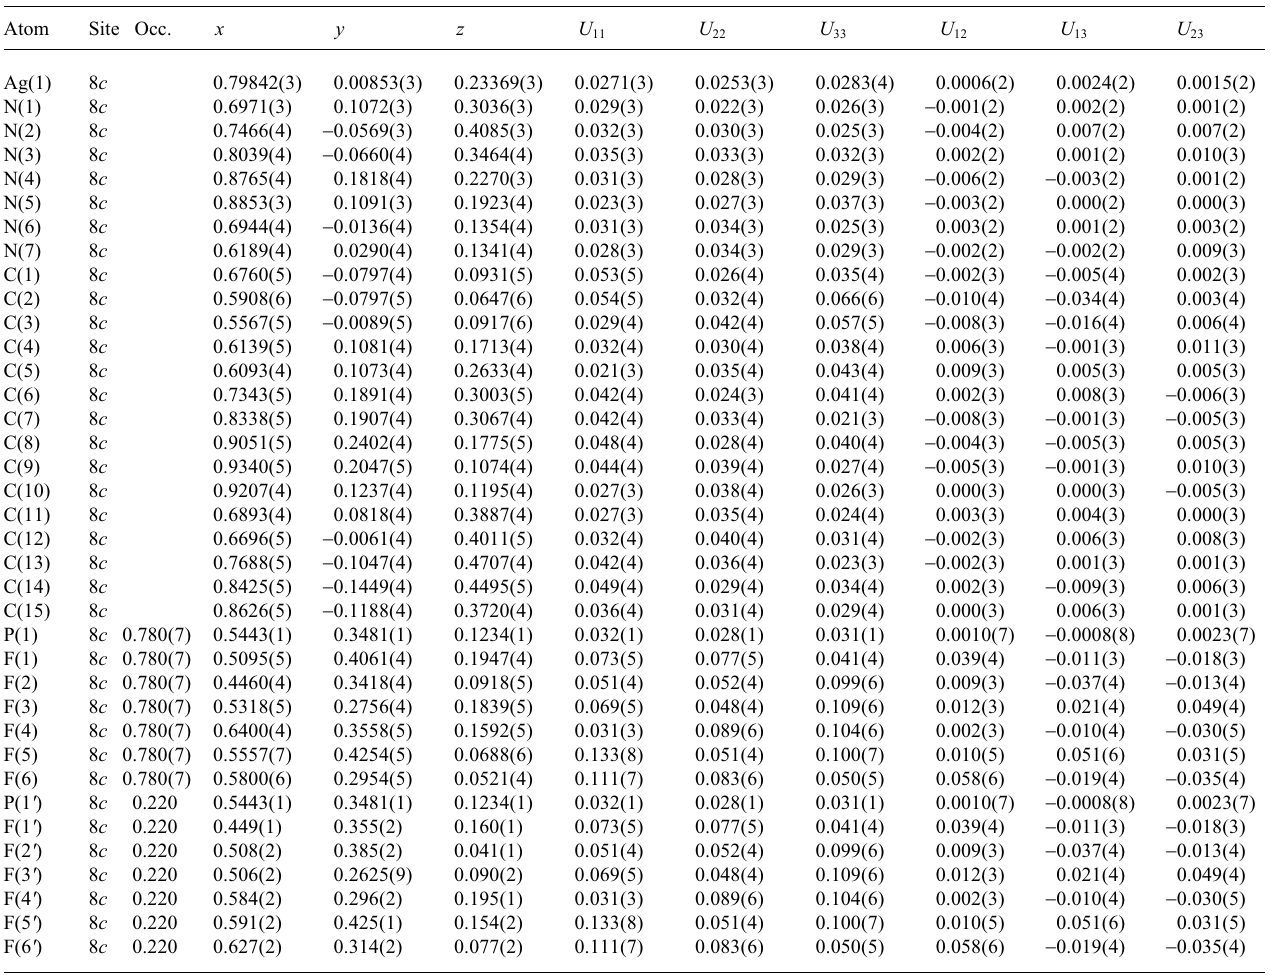
Table 3. Atomic coordinates and displacement parameters (in Å 2